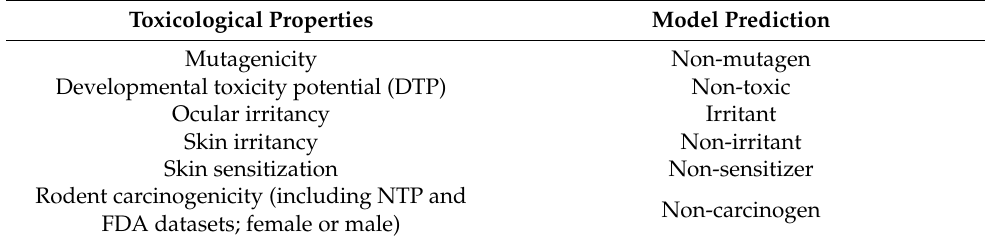
Table 3. Prediction of toxicological